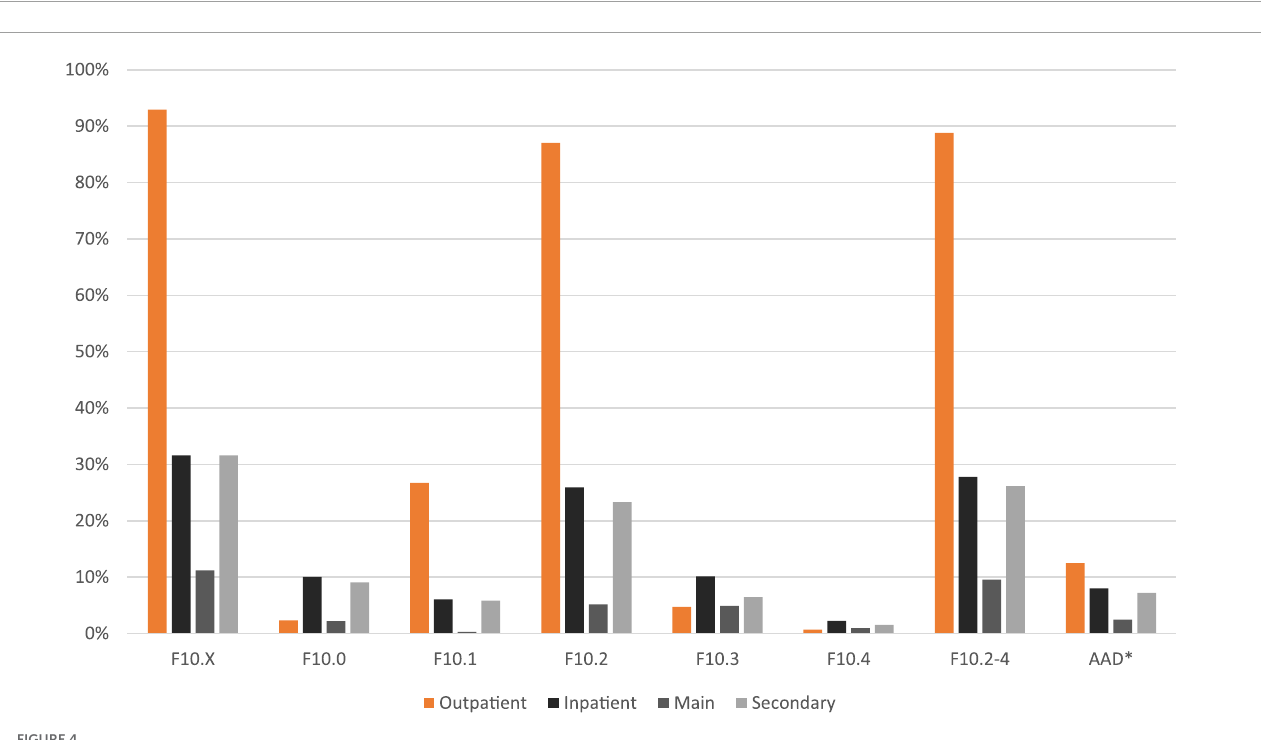
FIGURE4 Diagnosis and diagnosis setting of persons with an alcohol dependence syndrome diagnosis (F10.2–4) but without addiction-specific care in the statutory health insurances’ (SHIs) population in 2016/2017. Outpatient (confirmed diagnosis only), inpatient (main or secondary diagnosis); the proportion of individuals in statutory public health insurances’ population with a diagnosis of F10.2–4 but without addiction-specific care: n = 5,097. ∗ AAD: alcohol-attributable diagnoses include E24.4, G31.2, G62.1, G72.1, I42.6, K29.2, K70.X, K86.0, O35.4, P04.3, and